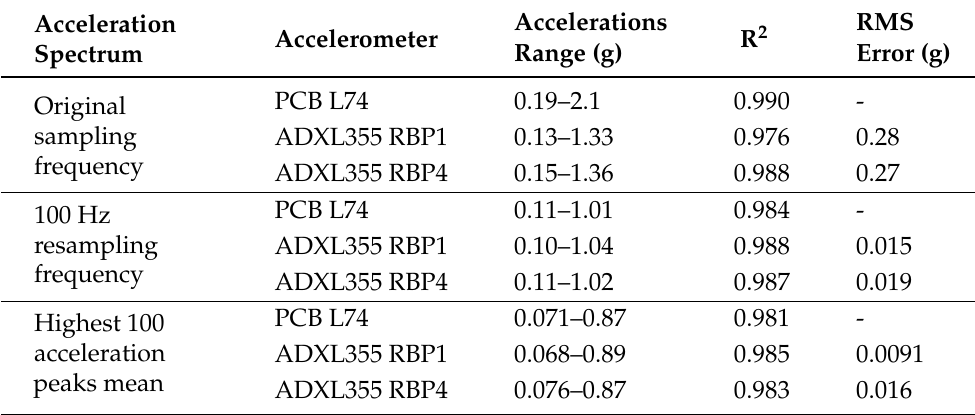
Figure 14. Acceleration spectra for the 0.75 cm displacement frequency chirp: ( a ) Maximum accelera- tion spectrum from original sampling frequency. ( b ) Maximum acceleration spectrum from 100 Hz resampling frequency. ( c ) Acceleration spectrum from the mean of the highest 100 acceleration peaks from 100 Hz resampling frequency. Table 6. Summary of the results obtained from the 0.75 cm displacement frequency chirp.